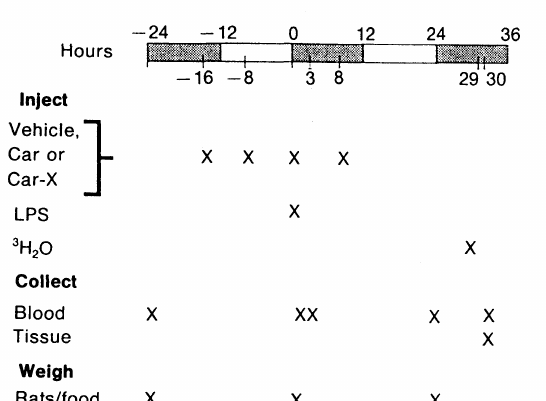
___ __. FIG. 2. Experimental protocol. At -16 h, -8 h, and at zero time, animals (17/group) were injected i.p. with NaHCO3 buffer vehicle carnitine, VBTcarnitine or the short-chain acids of VBTcarnitine. At zero time all animals except the NaHCO3 controls were injected concurrently with LPS. At 8 h post-LPS the respective groups received a final injection of NaHCO3 buffer carnitines or short-chain acids. At -29 h animals (six from each group) were injected i.p. with 3H20, killed at 30 h, and liver, muscle and blood collected. Tailvein blood was collected at 24 h pre-LPS, at zero time, and at 3 and 24 h post-LPS. Rats and chow were weighed at 24 h pre-LPS and at 24 h intervals. Animal health and survival were monitored regularly for 96 h post-LPS. See methods for specific details. Car carnitine, Car-X X-VBTcarnitine, LPS